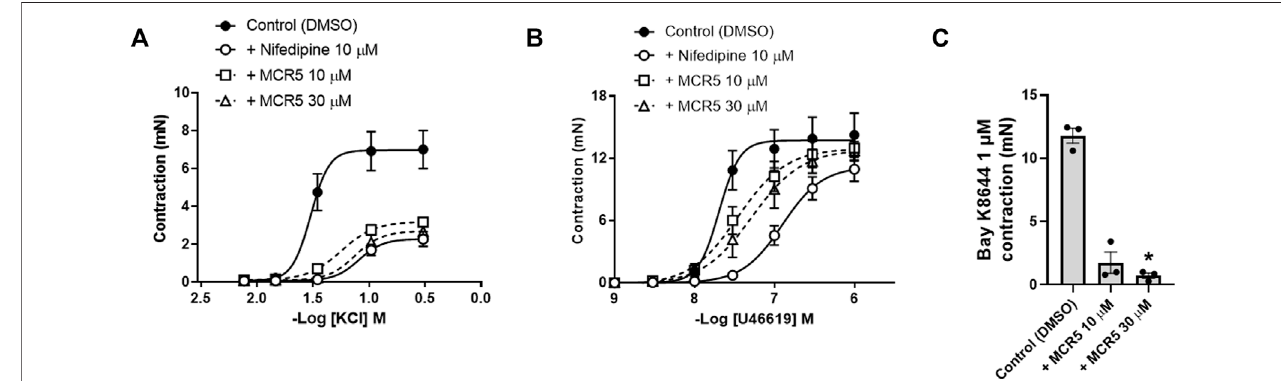
FIGURE 4 | In fl uence of MCR5 on smooth muscle voltage-gated Ca 2+ channels. Concentration-response contraction curves to KCl (A) and U46619 (B) in aortic rings from young OF1 mice in the absence (control) or presence of the L-type voltage-gated Ca 2+ channel blocker nifedipine (10 µM) or MCR5 (10 and 30 µM). (C)